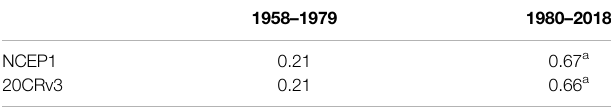
TABLE 1 | Correlation coef fi cients between the BOBSM and SCSSM onsets during the period of 1958 – 1979 and 1980 – 2018,